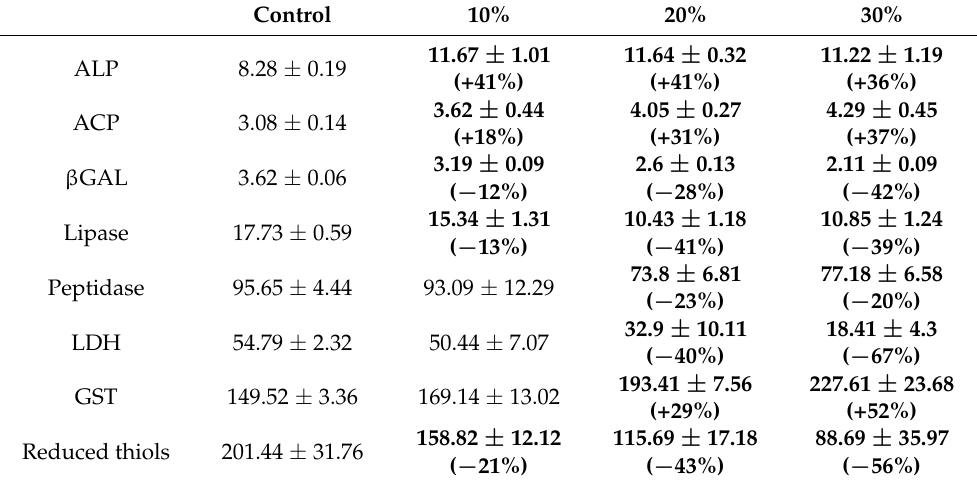
Table 3. Biochemical markers of daphnid physiology upon exposure to a mixture of eight chemi- cals. Data represent mean ± standard deviation (N = 4) of enzyme activity. Enzyme activity was expressed as units/mg protein for lactate dehydrogenase (LDH), lipase, β -galactosidase and phos- phatases, as munits/mg protein for GST, and for reduced thiols in nmoles/mg protein. Bold font indicates statistically significant difference by one-way ANOVA followed by comparison with the unexposed